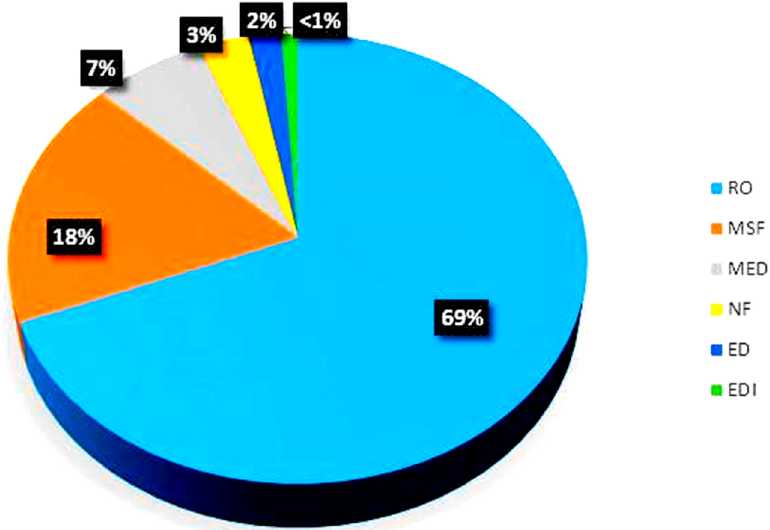
Figure 1. Distribution of water desalination applied techniques for desalinated water production all over the world (RO: reverse osmosis, MSF: multi-stage flash, MED: membrane distillation, NF: nanofiltration, ED: electrodialysis, EDI: electrodeionization).